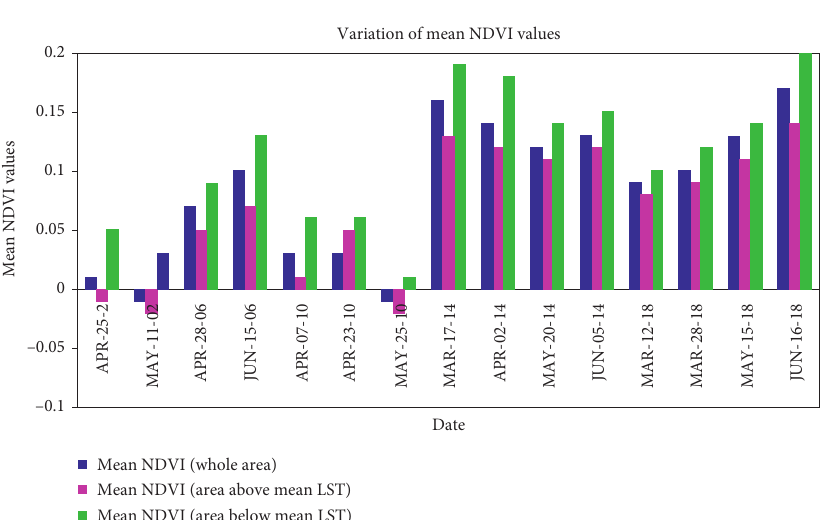
Figure 9: Temporal variation of mean NDVI for each satellite image.